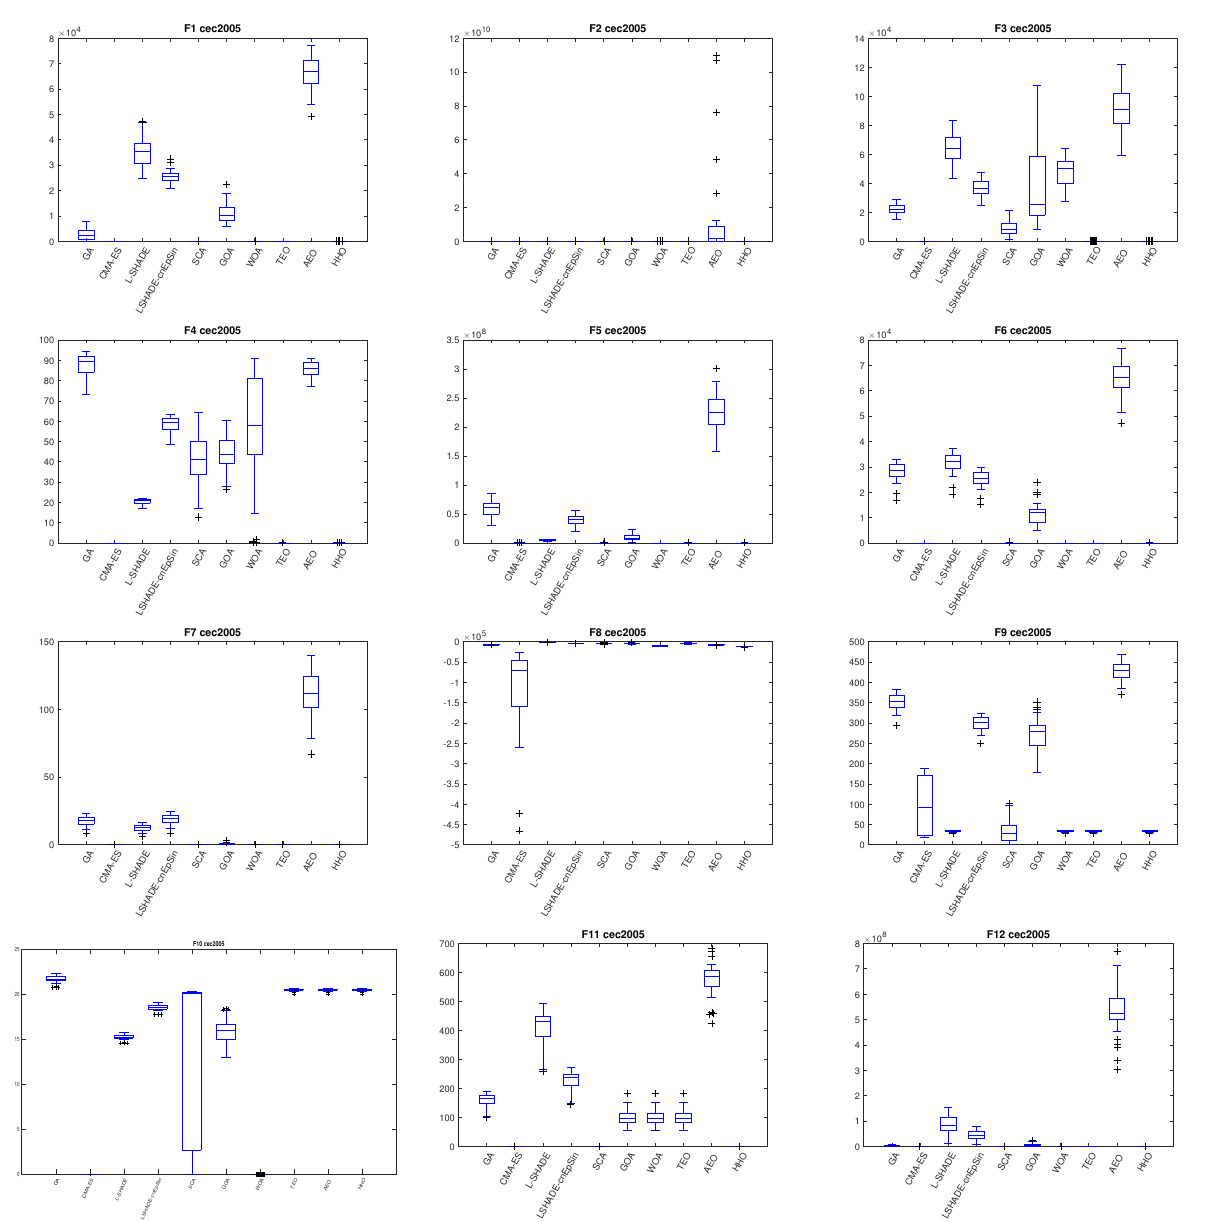
Figure 4. Boxplot of some functions from F1–F12 for all